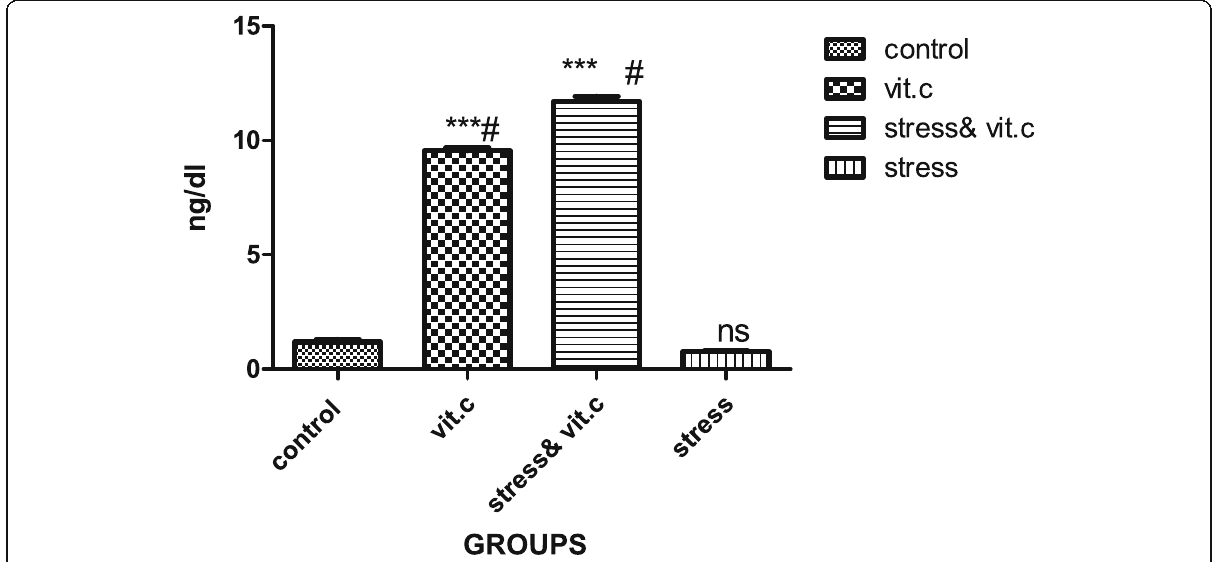
Fig. 9 Effect of chronic variable stress with vitamin C supplementation on serum level of testosterone hormone in Wistar rats. *** p < 0.0001, # significant when compared to stress only group, ns no